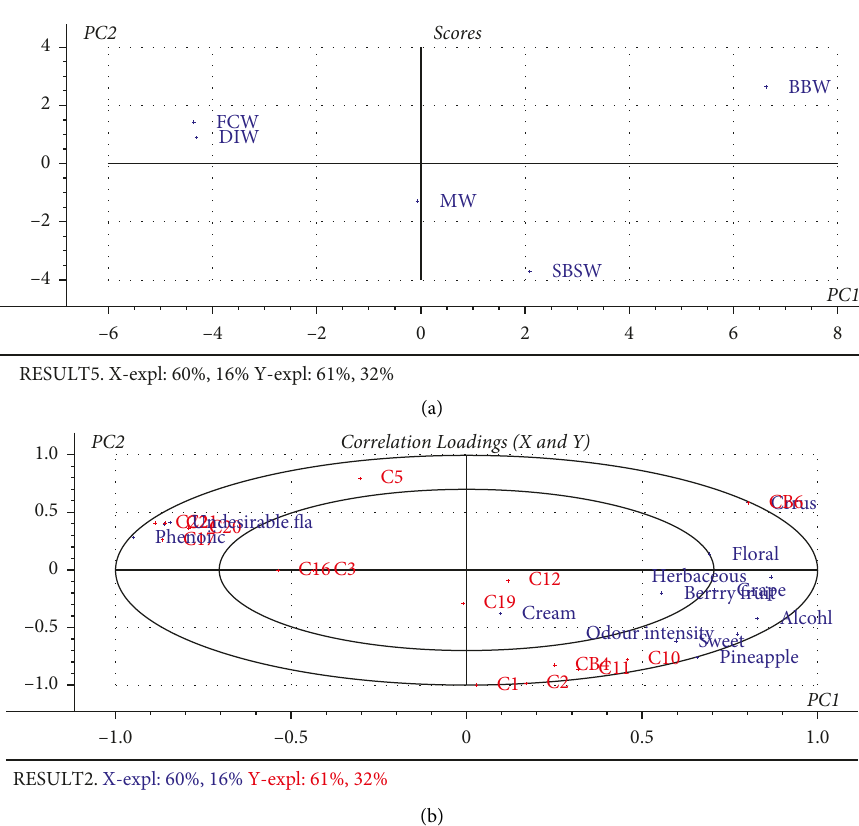
Figure 2: scores plot for five home-brewed wines (a). Correlation between loadings plots of X-variables for 22 volatiles compounds (OAV > 1 Table 4) and Y-variables for the 11 odor descriptors (Table 3)